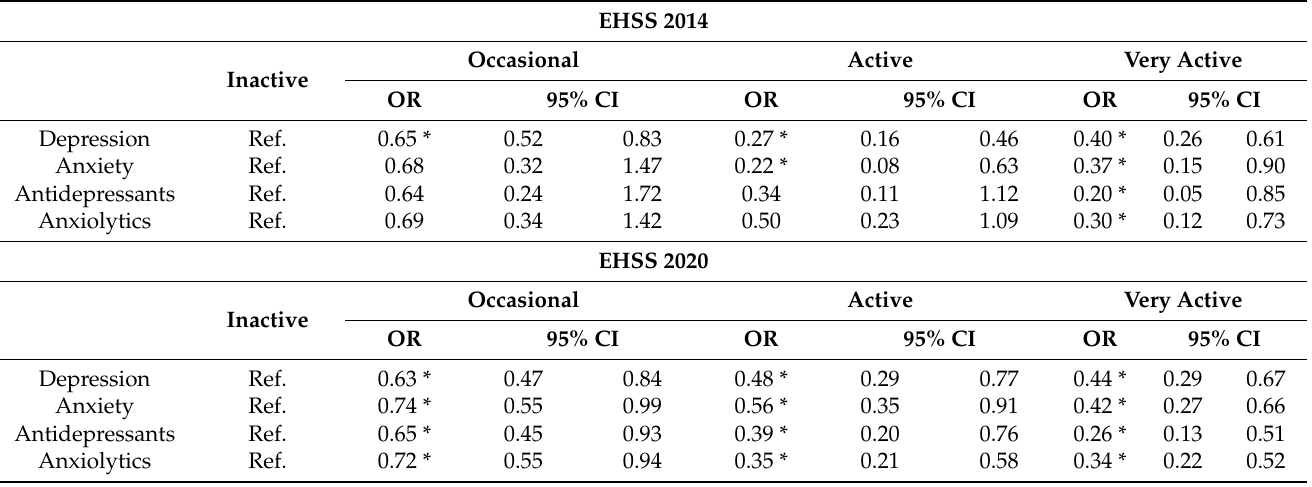
Table 2. Odds ratios of depression, anxiety and antidepressants and anxiolytics use according to the physical activity frequency in Spanish informal caregivers (EHSS2014–2020).